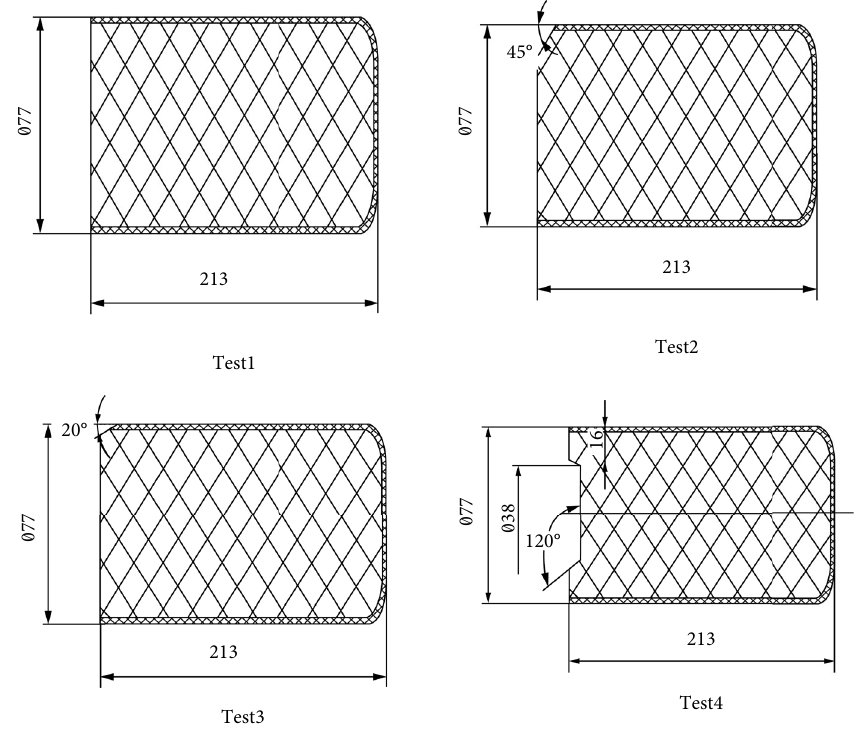
Figure 2: Grain con fi guration. Table 1: Main parameters of grain end.